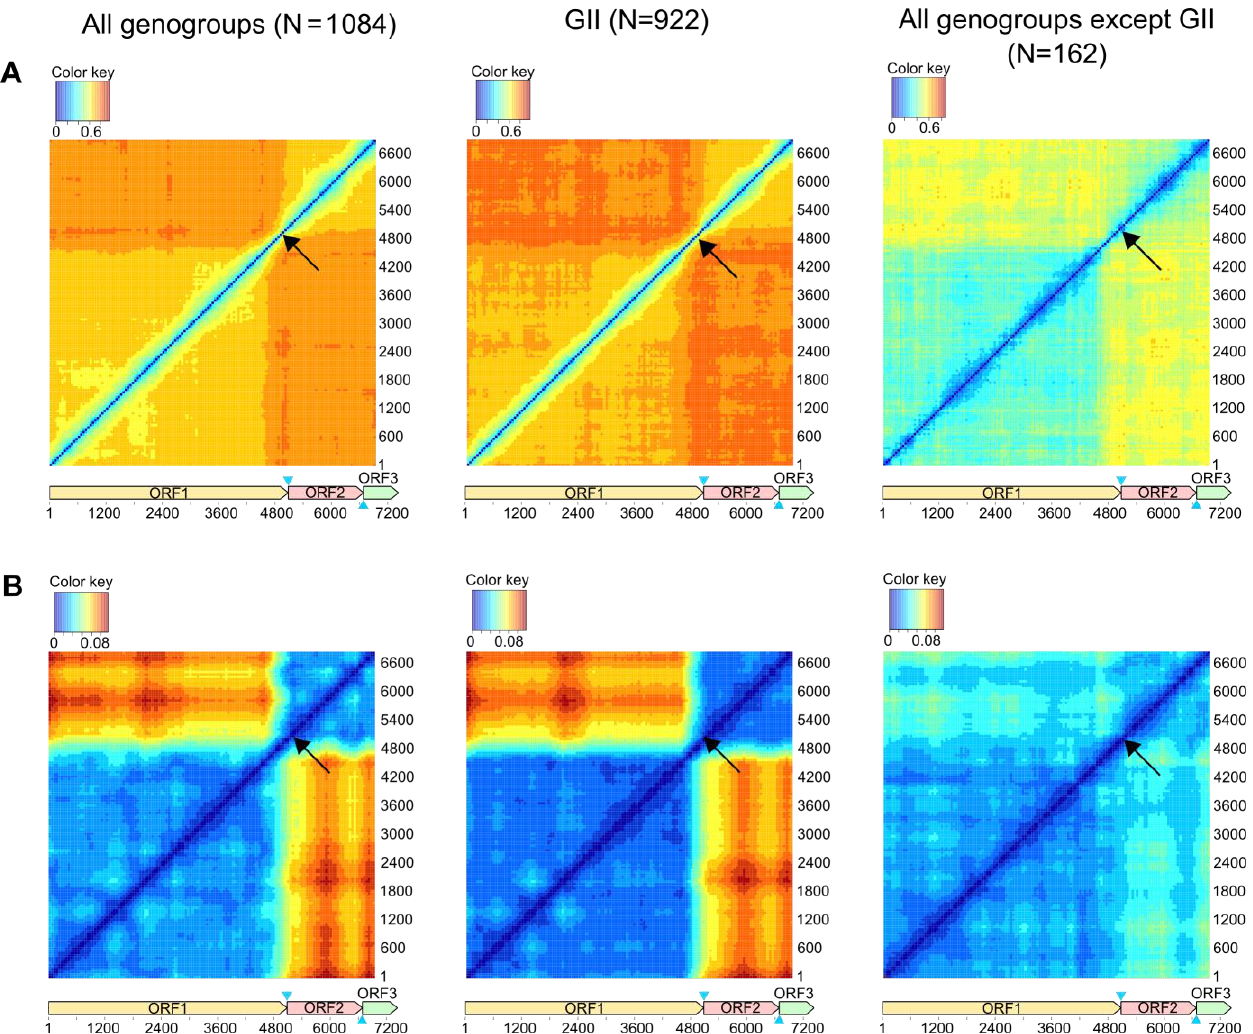
Figure 2. The recombination in ORF1/2 junction is the most prominent in all genogroups of noroviruses, but can be suggested elsewhere in the genome. Recombination incidence in norovirus genome detected by phylogenetic compatibility matrices ( A ) and pairwise distance deviation (PDD) matrices ( B ) for noroviruses with the following parameters: window = 600 nt, step = 50 nt. Axes indicate the position of a window start in the alignment. Colors reflect normalized Robinson–Foulds distances (A) and root-mean-square error (RMSE) in pairwise distance correspondence (PDC) plots built for the corresponding alignment window pairs ( B ). Blue triangles indicate the overlaps between ORF1 and ORF2 (17 nt), ORF2 and ORF3 (1 nt) that were duplicated in the alignment of concatenated ORFs. Black arrows indicate the ORF1/2 junction.